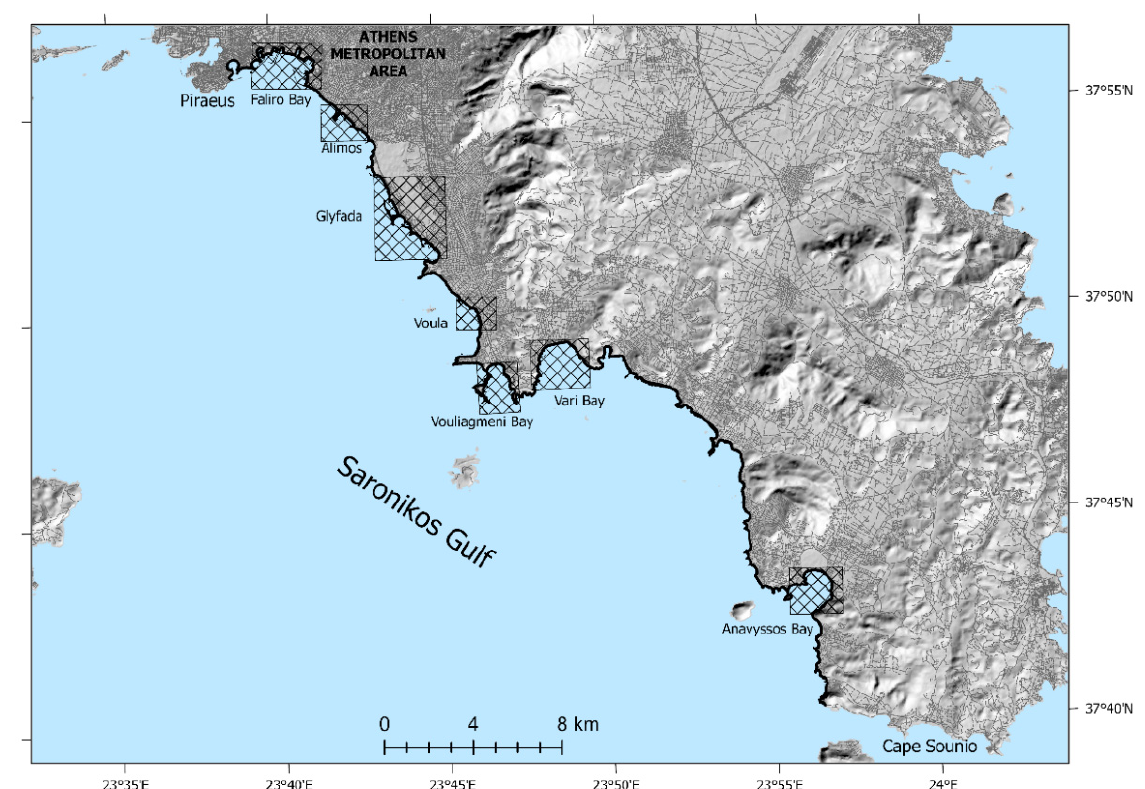
Figure 2. Spatial distribution of subareas in which the shoreline changes were measured.